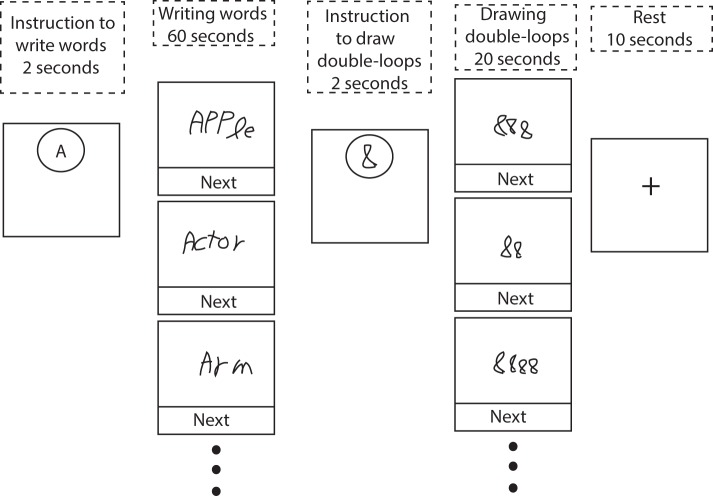
Schematic of the phonemic fluency task involving written responses, and a control condition consisting of drawing symbol strings composed of double-loops. At the beginning of each block, subjects were presented with a 2 s instruction image. Subjects received real-time visual feedback of their hand-writing during task performance. See text for further details.